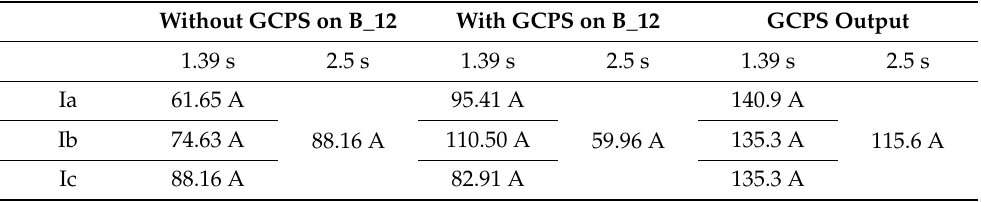
Table 5. Electric current values at 1.39 s, during short-circuit, and at 2.5 s, in steady state condition.